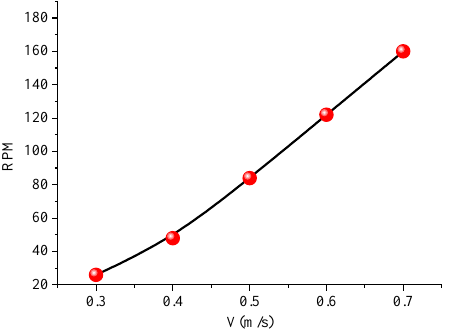
Figure 8. The relationship between the rotation and the velocity of incoming